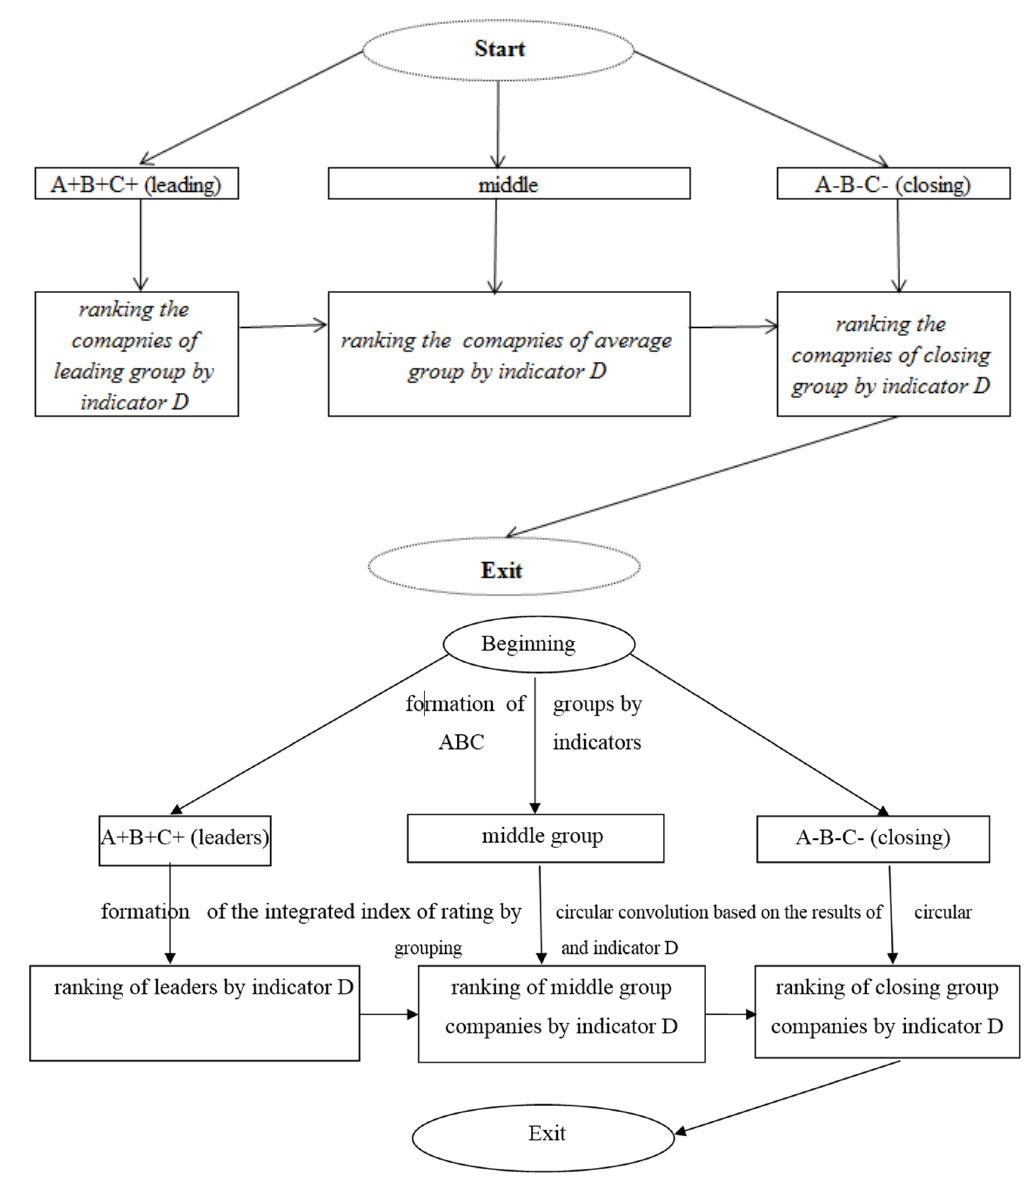
Figure 1. Scheme of information flows of integrated rating by circular convolution (RCC).